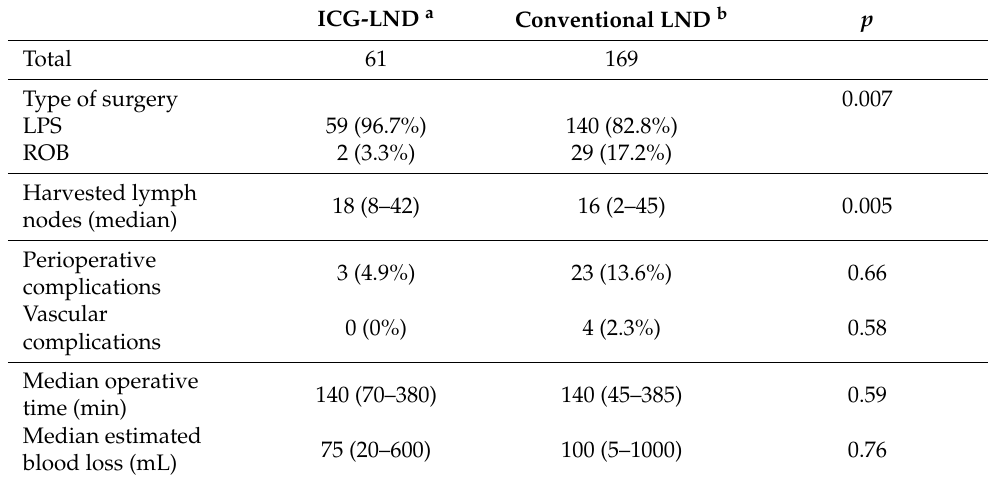
Table 4. Perioperative